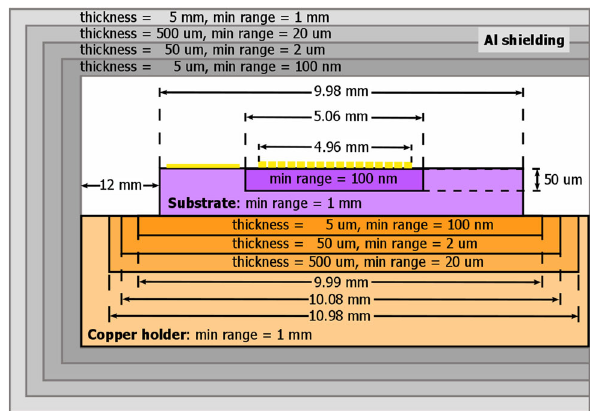
Fig. 4 Scheme of the set-up around the ECHo-1k chip (not to scale). The dimensions and production thresholds of the subvolumes of the shielding (grey), substrate (purple) and copper holder (orange) can be